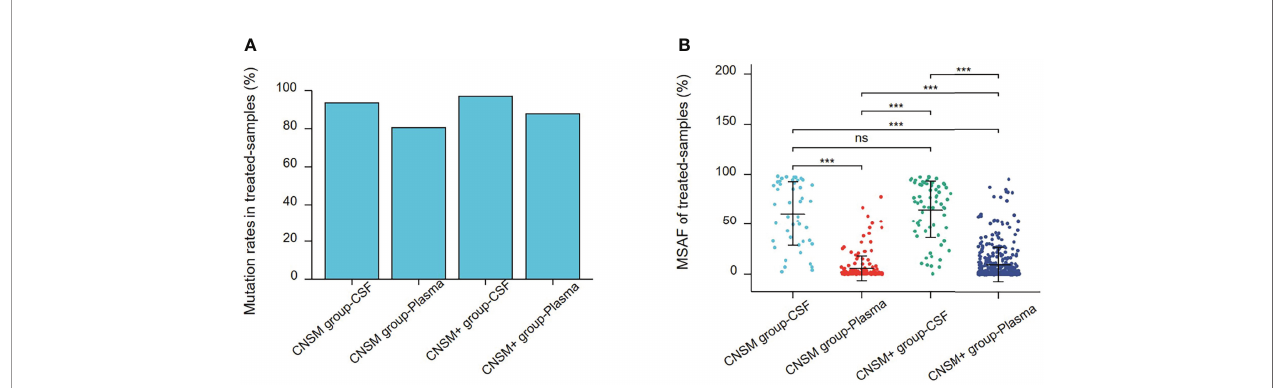
FIGURE 5 | Mutations rates and MSAF of treated samples. (A) Mutations detected in different treated samples from patients in the treated CNSM or CNSM+ groups. (B) MSAFs of CSF and plasma samples from patients in the treated CNSM or CNSM+ groups. ns, p ≥ 0.05; ***p < 0.001. CNSM group, patients had distant metastases only from the CNS, CNSM+ group, patients with other organ involvement and distant metastases other than